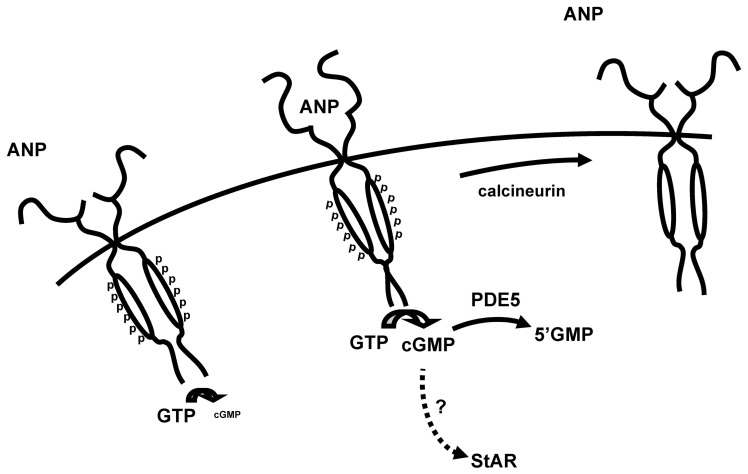
Schematic depicts the regulation of ANP-induced cGMP signals in MA-10 cells.ANP binds to phosphorylated receptors, triggering increased cGMP synthesis. Calcineurin dephosphorylates NPR-A, blunting cGMP synthesis. Cyclic GMP is hydrolyzed by PDE5. The resulting transient increase in cGMP levels is believed to lead to an increase in steroidogenic acute regulatory protein (StAR) activity – the rate limiting step in steroidogenesis. The molecular mechanisms underlying ANP-induced increases in StAR activity remain unclear. In the absence of ligand, phosphorylated NPR-A has a low level of cGMP synthesis. Thus, a balance of phosphorylation by an unknown kinase and dephosphorylation by calcineurin determines the levels of basal and ANP-induced cGMP production.